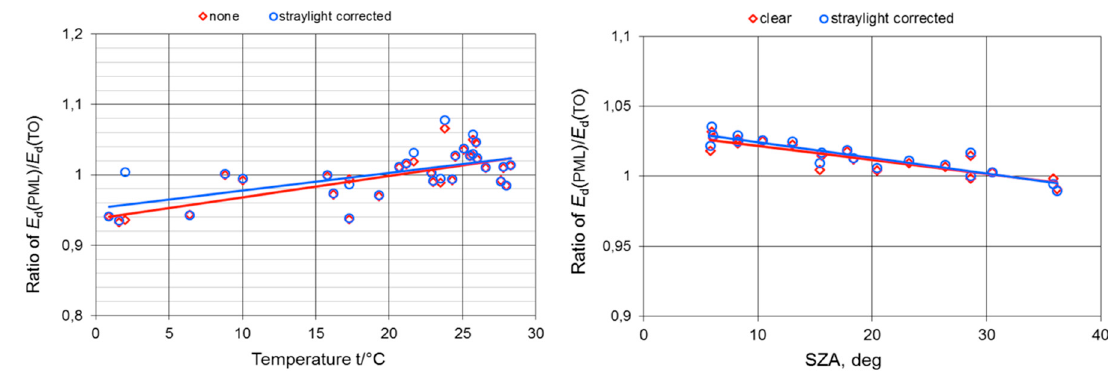
Figure 16. Di ff erence in downwelling irradiance between PML and TO sensors as a function of ambient Figure 16. Difference in downwelling irradiance between PML and TO sensors as a function of temperature ( left ) and solar zenith angle (SZA, right ambient temperature ( left ) and solar zenith angle (SZA, right ).